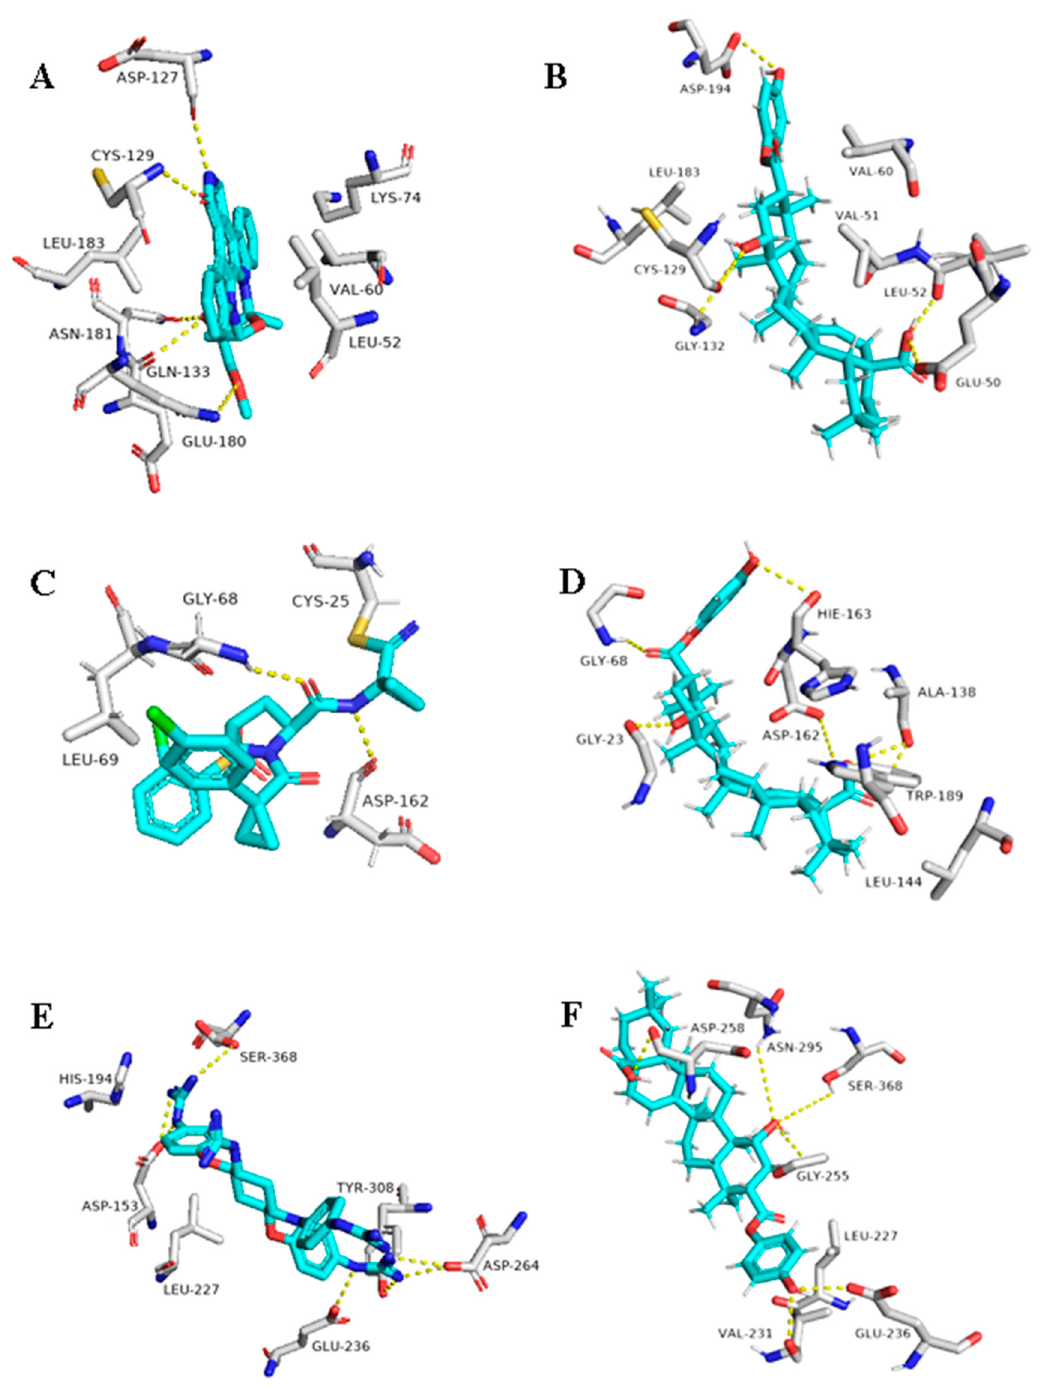
Figure 9. Binding modes of 1ß-Hydroxyaleuritolic acid 3- p -hydroxybenzoate (11) inside the human-based targets. ( B , D , F ) Interactions inside both AAK1, cathepsin L, and furin, respectively. ( A , C , E ) co-crystallized ligands of AAK1, cathepsin L, and furin, respectively.